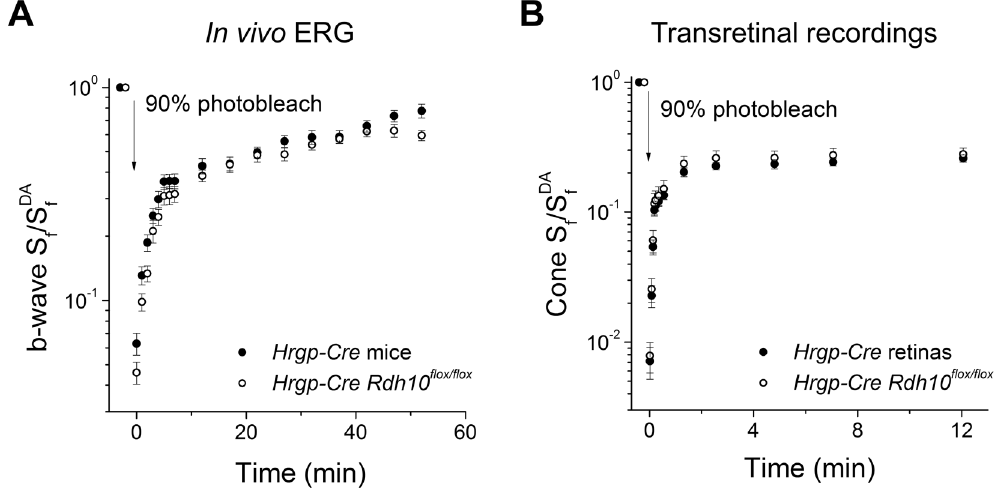
Figure 4. Deletion of RDH10 in cones does not affect cone dark adaptation. ( A ) Normalized cone b-wave sensitivity (b-wave S f /b-wave S f DA ) recovery following 90% pigment photobleach from HrgpP-Cre control (n = 18, filled symbols) and Hrgp-Cre Rdh10 flox/flox (n = 18, open symbols) mice measured by in vivo ERG recordings. ( B ) Normalized cone sensitivity (S f /S fDA ) recovery following 90% pigment photobleach in Hrgp-Cre control (n = 13, filled symbols) and Hrgp-Cre Rdh10 flox/flox (n = 13, open symbols) isolated retinas measured